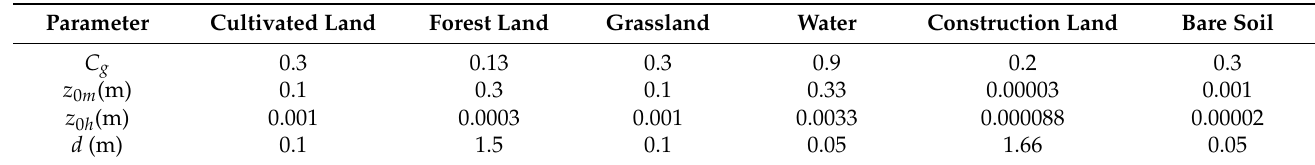
Table 3. Parameters used in this